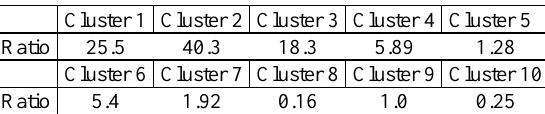
Table 1. The ratio of trajectory